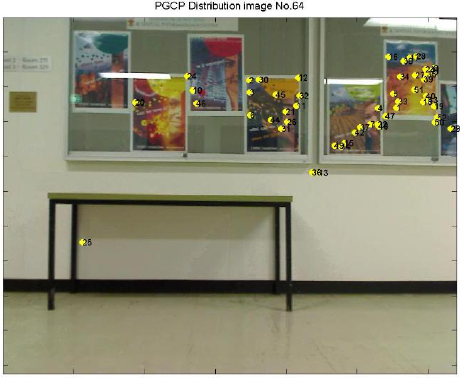
Figure 17. PGCPs (yellow dots) on real time query image No.